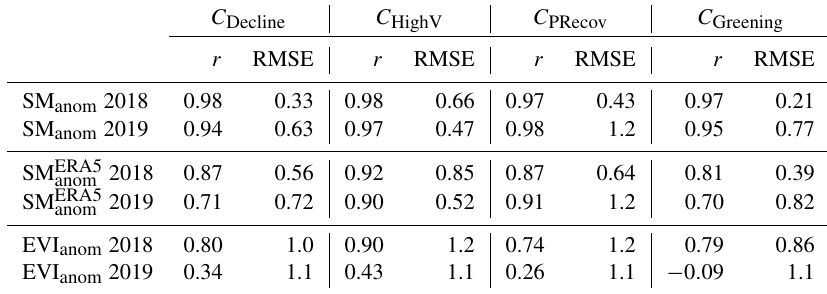
Table 1. Correlation between growing season (gs, April–September) SM anom simulated by LSMs with SM anom from SoMo.ml and ERA5 and of EVI anom with GPP simulated by LSMs.